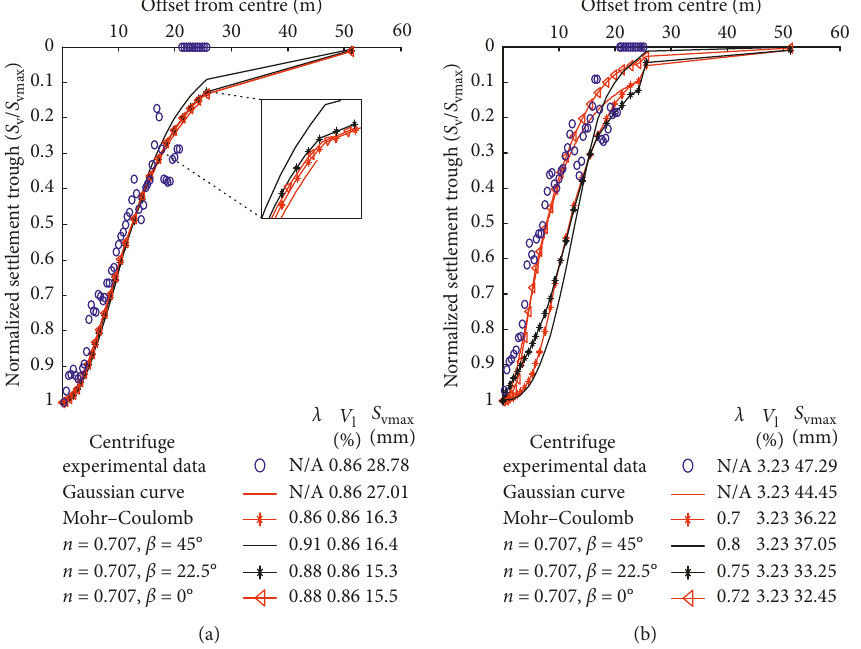
Figure 6: Normalized settlement profiles with various values of β : (a) V